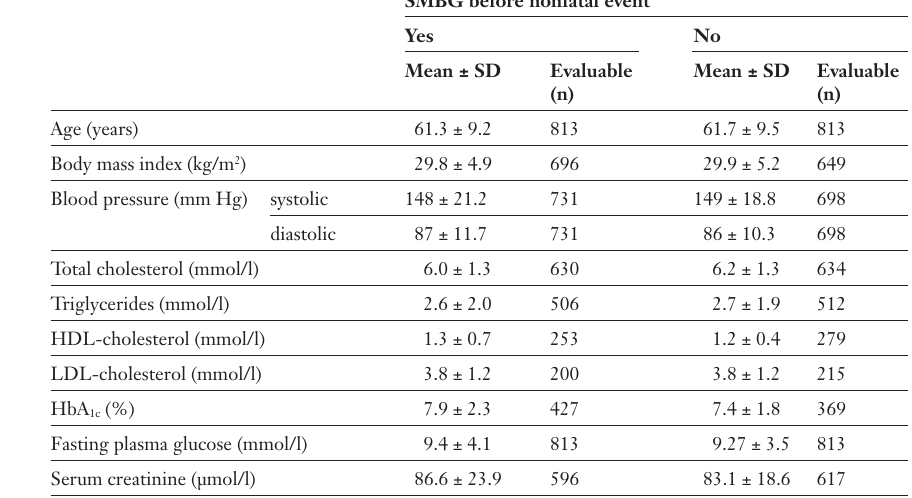
Baseline clinical